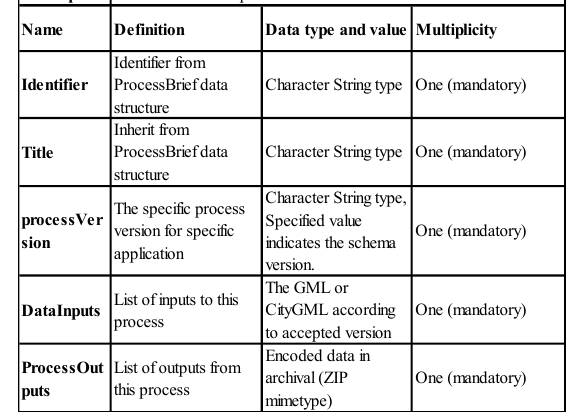
Table 4: The response of DescribeProcess